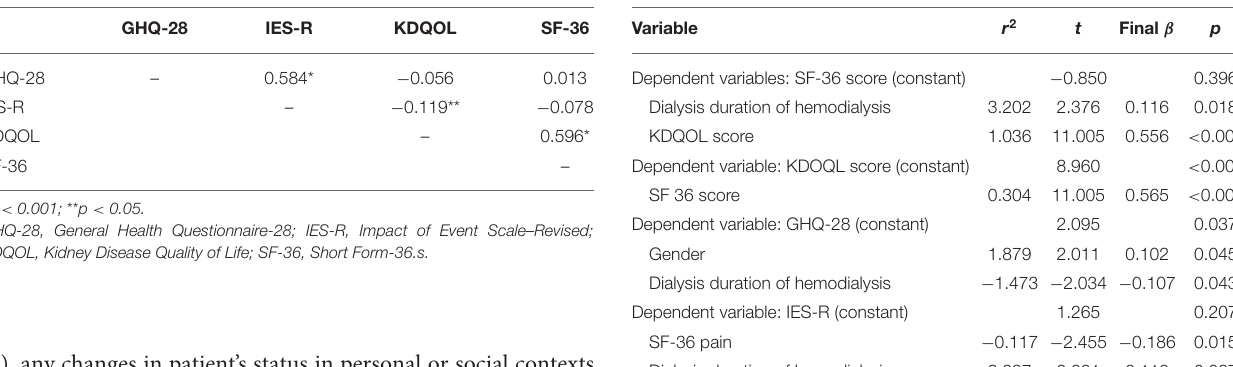
TABLE 6 | Multiple regression of dependent variables and related factors during ongoing COVID-19